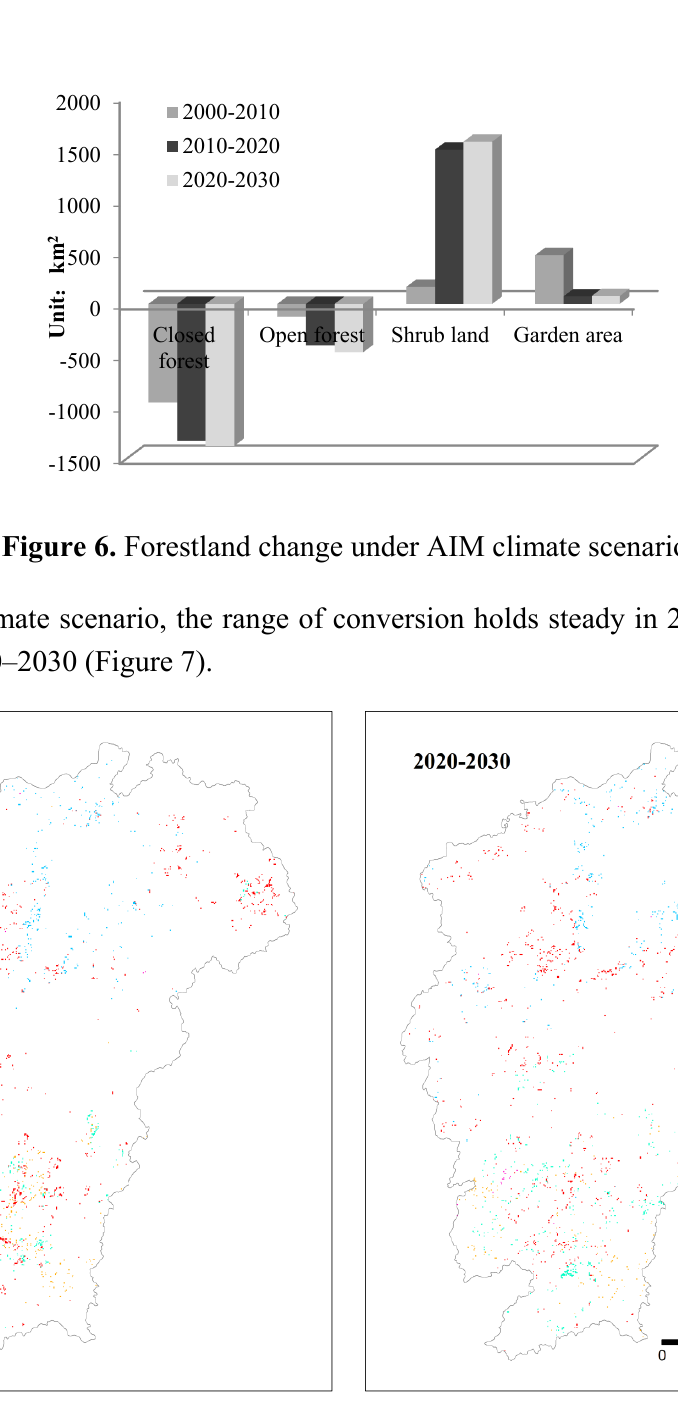
Figure 7. Conversion of forestland under the AIM climate scenario: ( 1 ) closed forest converted to non-forestland; ( 2 ) closed forest converted to other forest; ( 3 ) other forest converted to non-forestland; ( 4 ) shrub land converted to garden area; ( 5 ) non-forestland converted to